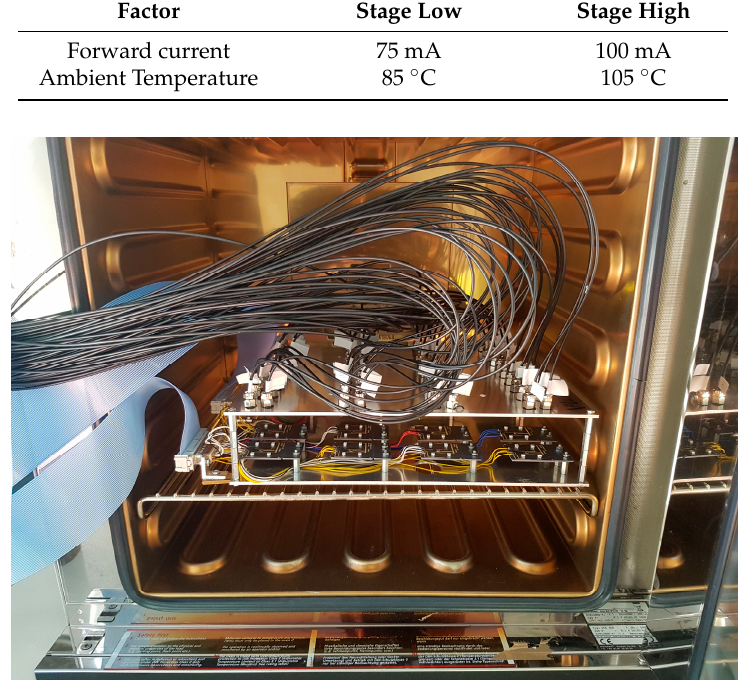
Figure 15. The external setup in the climatic chamber.